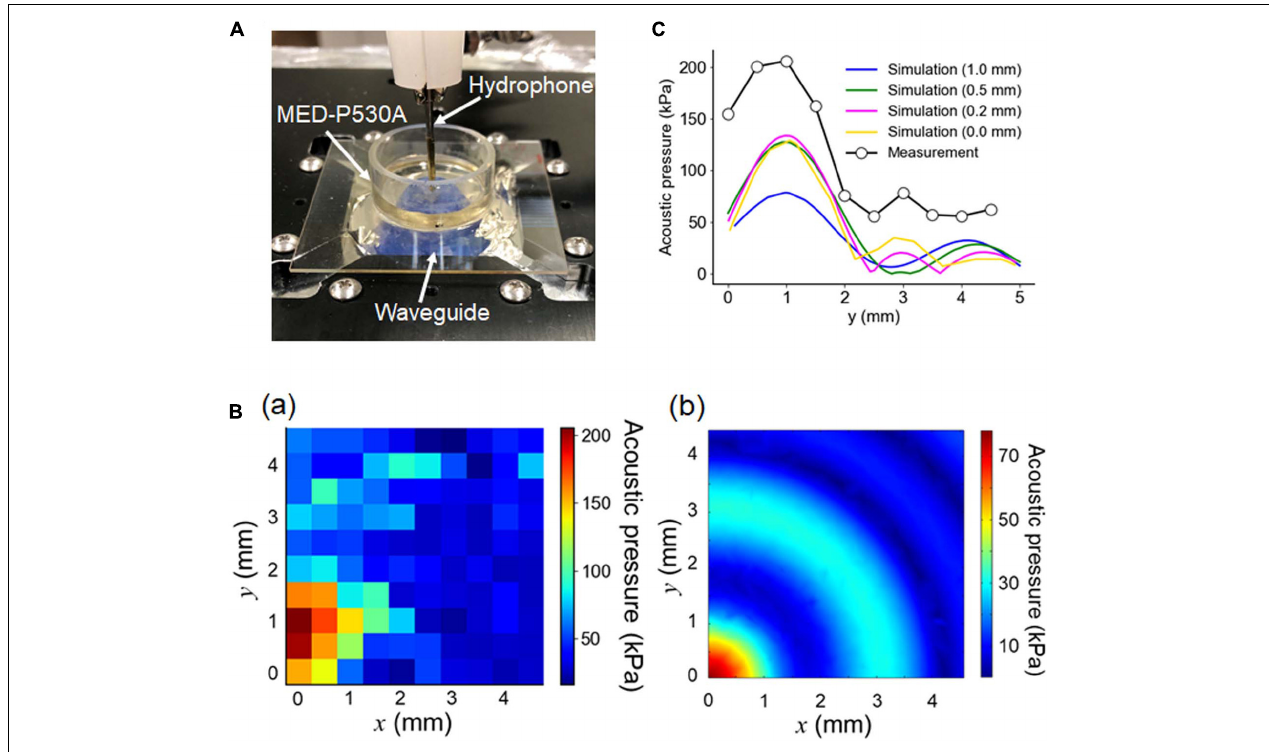
FIGURE 5 | Pressure measurement using a hydrophone. (A) Actual image of the experimental pressure measurement setup. For the optimally designed waveguide attached to an ultrasound transducer, the fluid pressure in the MEA chamber was measured using a needle hydrophone located 1.0 mm away from the surface of the MEA substrate. The height of the ACSF solution was 6.0 mm. (B) For one quadrant of the circular chamber, the fluid pressure was spatially measured, as illustrated in (a). During the experiment, the hydrophone was repositioned in 0.5 mm increments to a maximum distance of 4.5 mm on each axis ( x - and y - axes) from the center. The results of the corresponding numerical simulation for the 3D model, conducted under the same conditions, are illustrated in (b). (C) For the area of interest, the experimental pressure distribution on the y -axis (circle) and the corresponding simulated pressure distributions for the different distances (0, 0.2, 0.5, and 1.0 mm) between the MEA-substrate surface and the hydrophone tip were